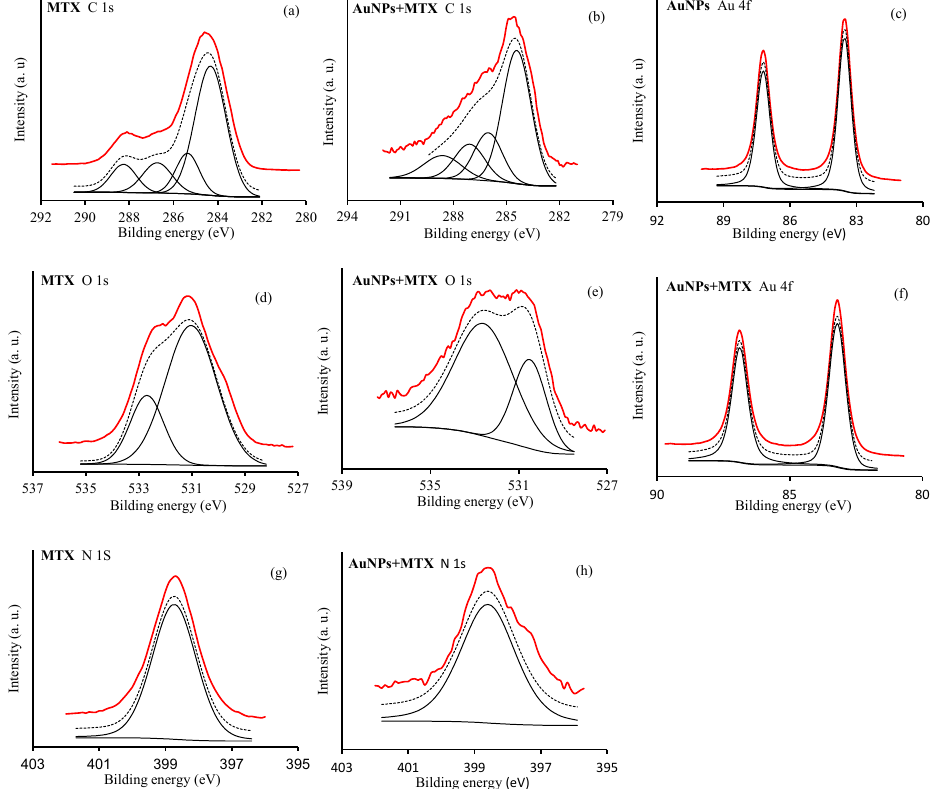
Figure 5. XPS spectra of regions C 1s: ( a , b ); O 1s: ( d , e ); N 1s: ( g , h ) and Au 4f: ( c , f ) of MTX, AuNPs and AuNP–MTX400.